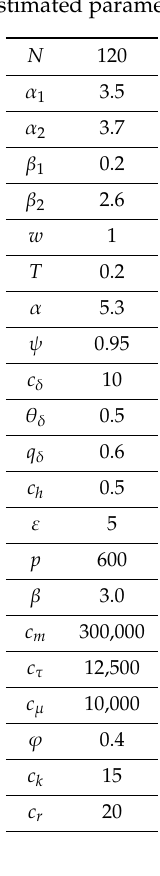
Table 1. Estimated parameter